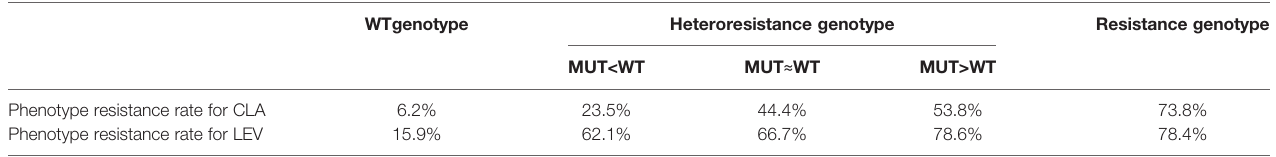
TABLE 1 | Phenotype resistance rates for biopsies with different